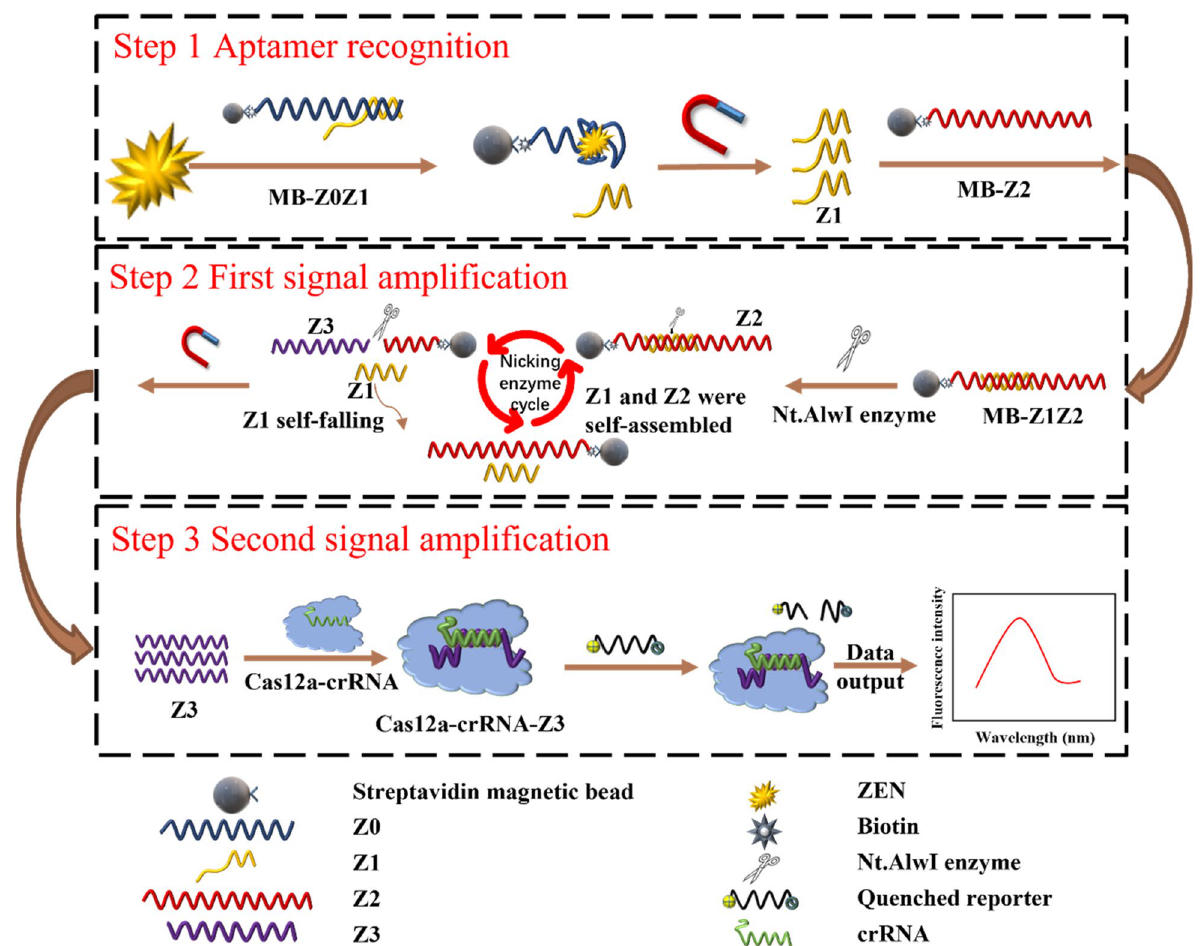
Fig. 5 . Magnetic-bead-assisted dual-signal-amplification aptasensor for sensitive ZEN detection based on the Nt.AlwI enzyme and the Cas12a enzyme. Step 1: The aptamer probe recognizes the ZEN toxin and causes Z1 to dissociate into solution by competitive binding. Step 2: After Z1 and Z2 were hybridized, the cutting activity of the Nt.AlwI enzyme was activated, the Z2 chain was cut to release Z3, Z1 was self-shed after the cutting was finished and it hybridized with Z2 again, and a large amount of Z3 was released by the enzyme-cutting signal amplification to achieve the first signal amplification. Step 3: The combination of Z3 and the Cas12a-crRNA complex activates trans-cleavage activity, non-specifically cleaving any ssDNA so that the added fluorescent signal molecule was cleaved and the quenched fluorescence was restored (Figure from Yao et al., Foods 2022, 11(3); Copyright: CC BY